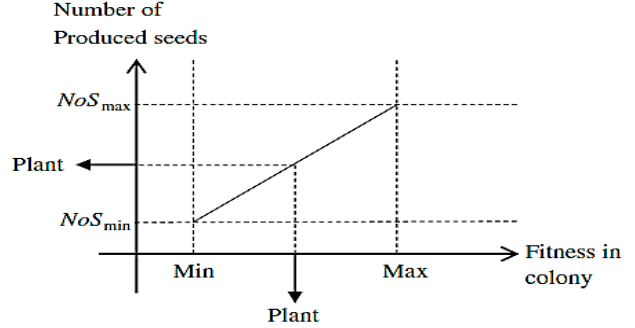
Figure 1. Production levels in the weed algorithm (WA).